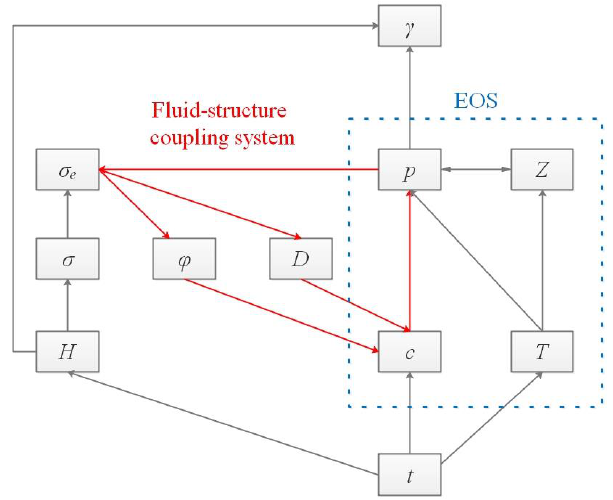
Figure 3. Parameters transfer in the reservoir pressure evolution model.